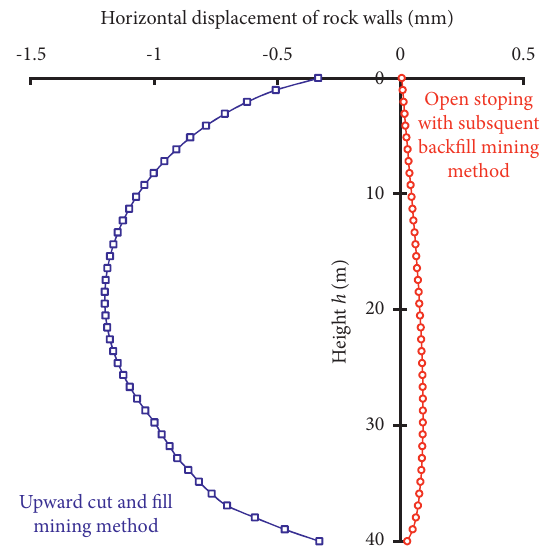
Figure 8: Convergent displacements along stope rock walls in two mining